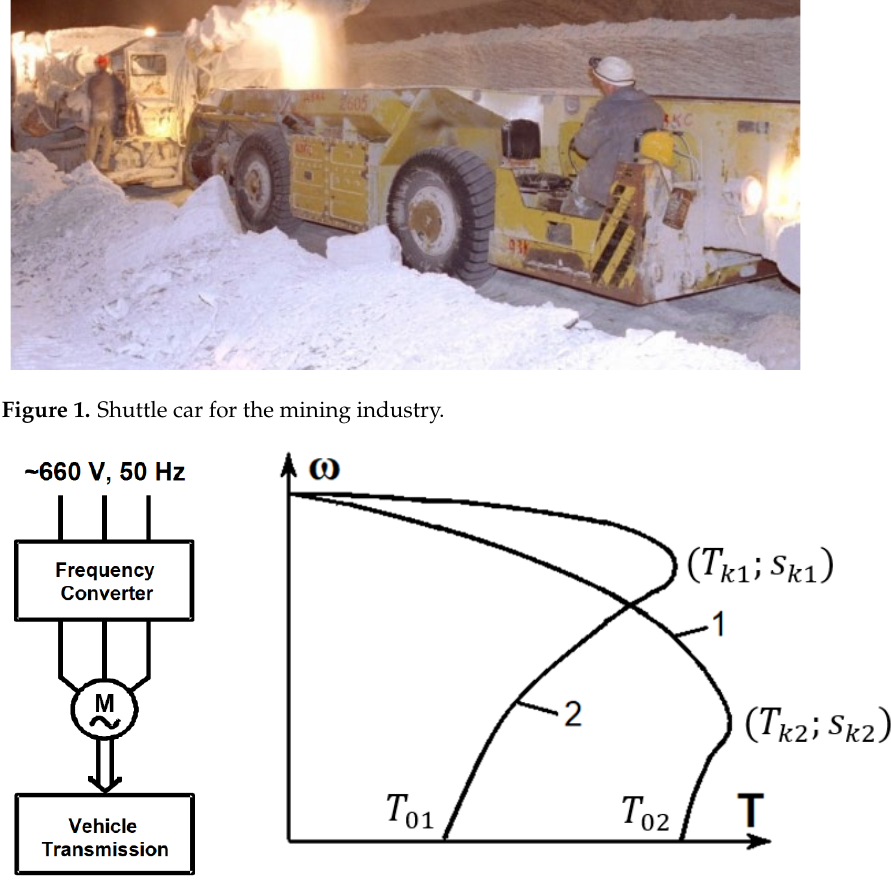
Figure 1. Shuttle car for the mining industry.